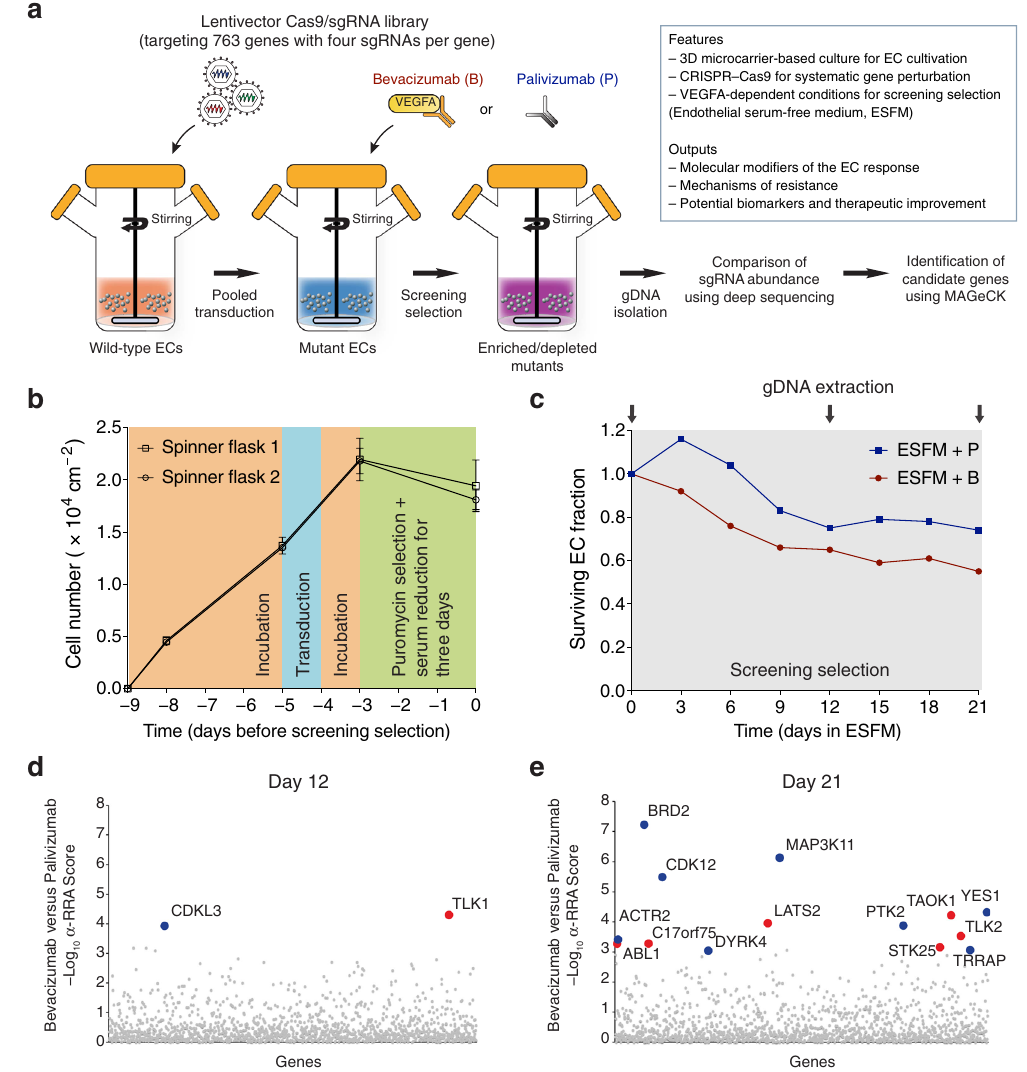
Fig. 2 Identi fi cation of EC response modi fi ers to bevacizumab. a Work fl ow of the 3D kinome-wide CRISPR screen. b Viable cell number determined before screening selection. Error bars represent ± SEM ( n = 2 independent experiments). c Cell survival during screening selection. Surviving EC fraction is the ratio of relative viable cell number on a speci fi c day versus that on day 0. Curves represent results from one experiment. d , e Identi fi cation of candidate genes. Candidate genes were identi fi ed using the α -RRA score (shown as – log 10 α -RRA score) on day 12 ( d ) or 21 ( e ). Blue or red dots represent candidate genes (FDR ≤ 0.3) identi fi ed from positive or negative selection (bevacizumab versus palivizumab), respectively. Small gray dots represent the neutral genes. Results represent two independent experiments ( n =